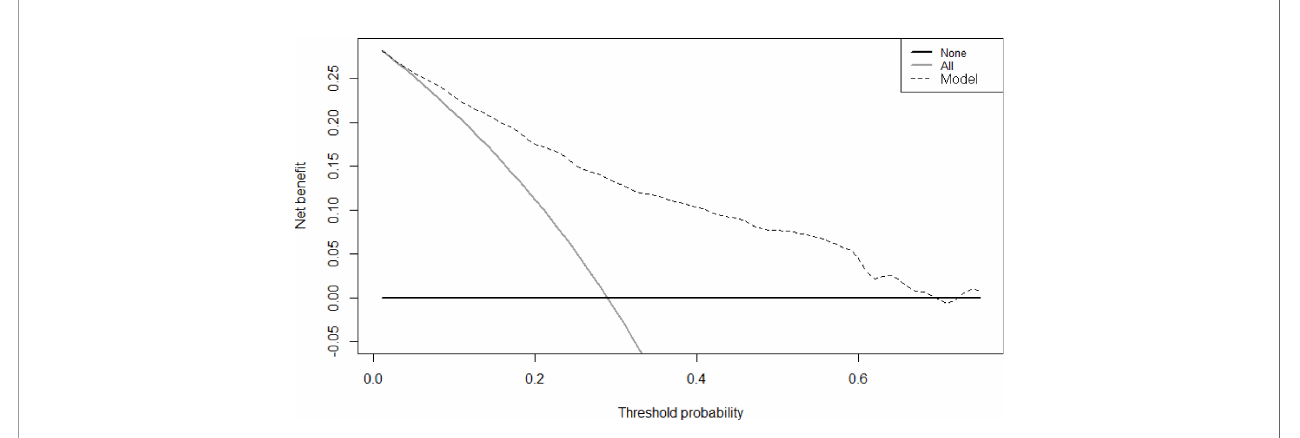
FIGURE 3 | Decision curve analysis for prediction model with